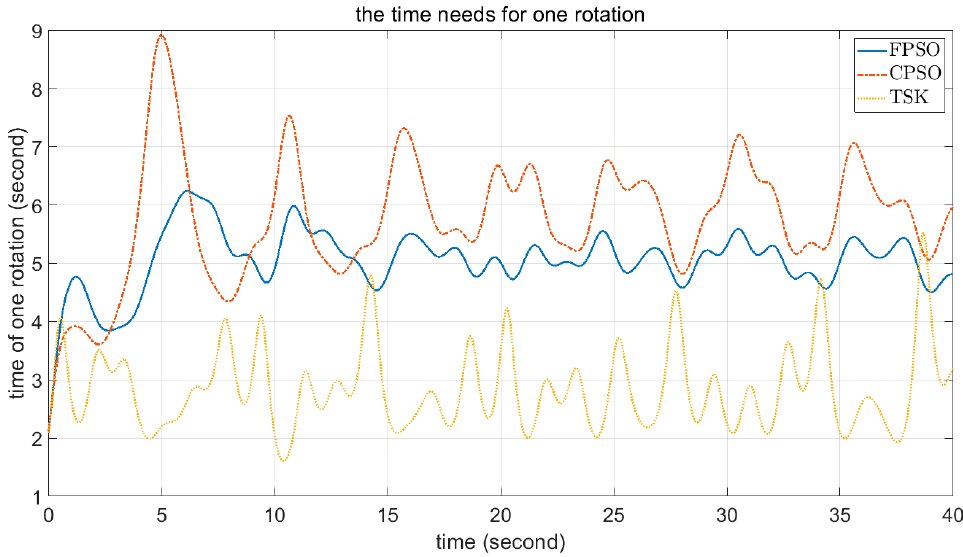
Figure 19. The time for one rotation in FPSO, CPSO, and fuzzy TSK.